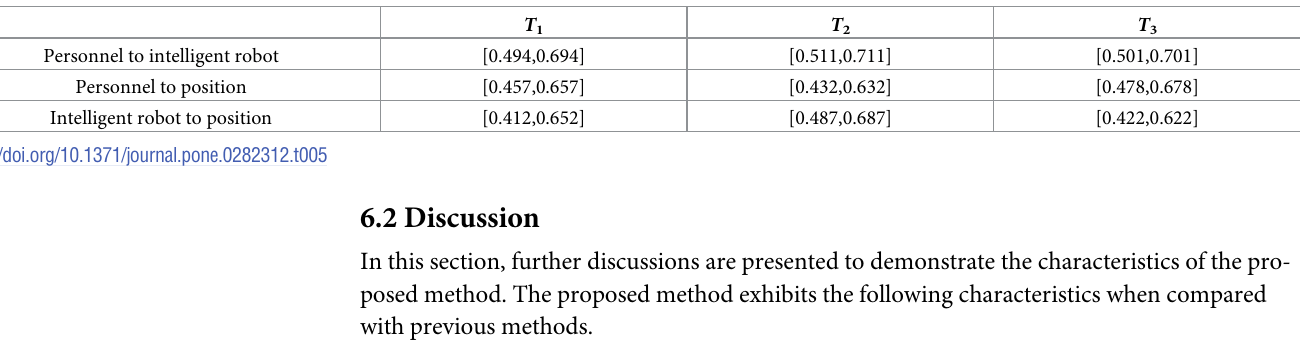
Table 5. Dynamic reference points of each stage.